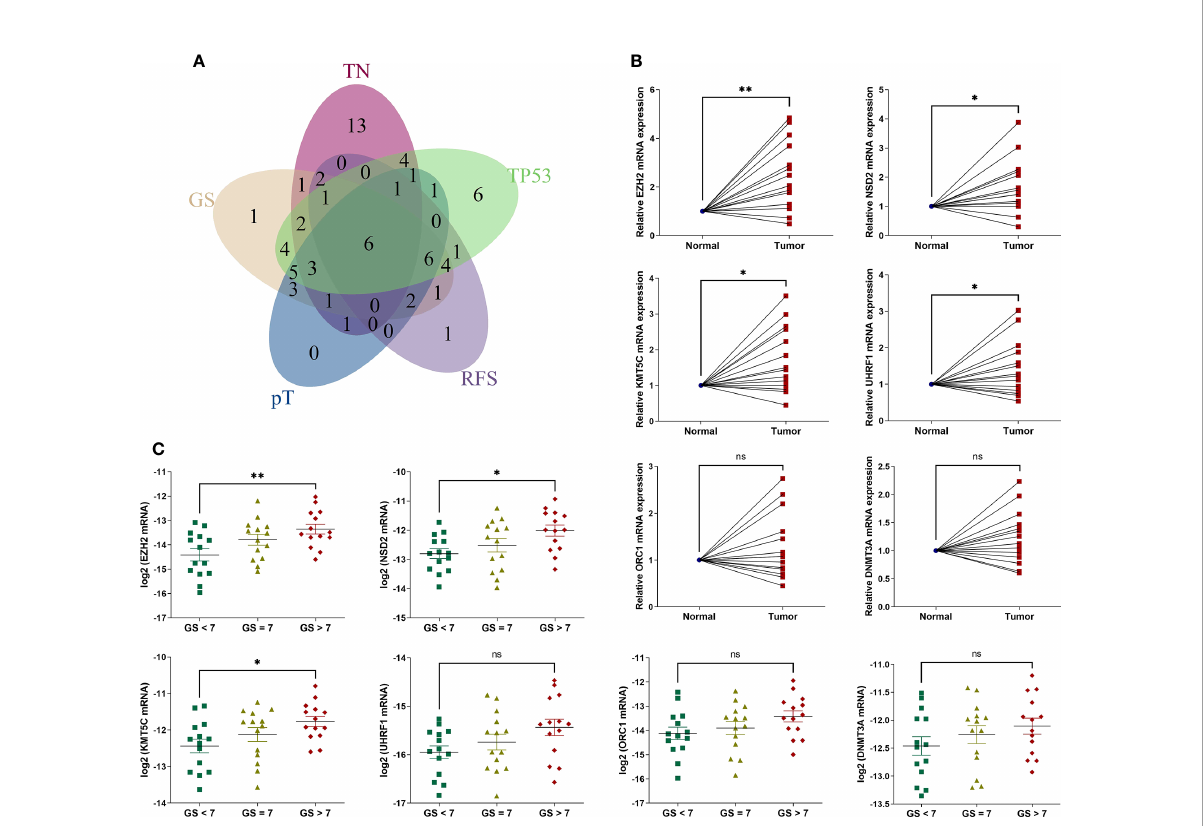
FIGURE 4 The expression levels of 6 intersecting differentially expressed HLM regulators in clinical PCa tissues. (A) The intersecting DEGs of 91 HLM regulators in relation to the comparisons of TN (tumor vs. normal PCa tissues), GS (GS > 7 vs. GS < 7), pT (T3 vs. T2), RFS (P value of univariate Cox regression analysis < 0.05), and TP53 (mutation vs. wild type) are shown as a Venn diagram. (B, C) The expression levels of 6 intersecting HLM regulators (EZH2, NSD2, KMT5C, UHRF1, ORC1, and DNMT3A) were compared in PCa vs. adjacent normal prostate tissues (B) and GS > 7 vs. GS = 7 vs. GS< 7 (C) . The results were normalized to adjacent normal tissues or those of endogenous reference genes. The means ± SEMs are shown in the graphs. ns P > 0.05; *P < 0.05; **P <